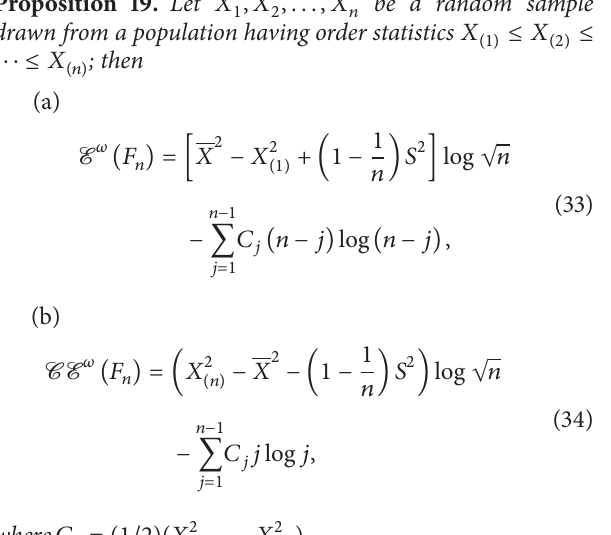
errors between empirical and real entropies. According to Table 1, the estimates are almost equal to real values of weighted cumulative information measures and MSE values are nearly